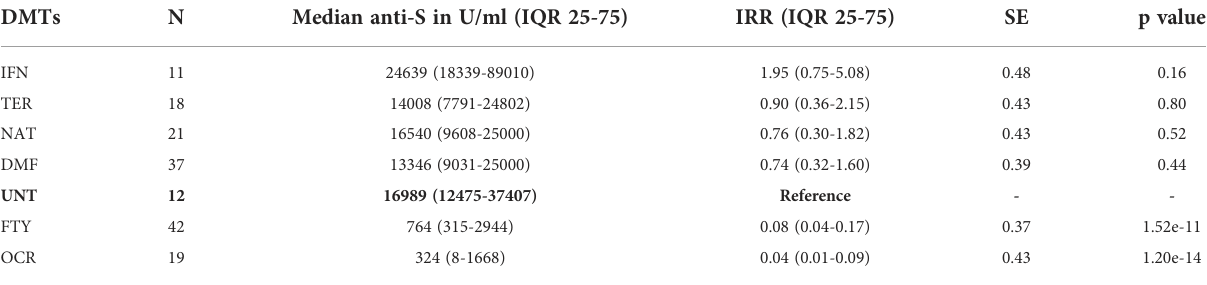
TABLE 3 Negative binomial generalized linear mixed-effects model of anti-S-Ab levels in untreated and treated MS patients (anti-N negative) one month after the BNT162b2 booster (T3). DMTs